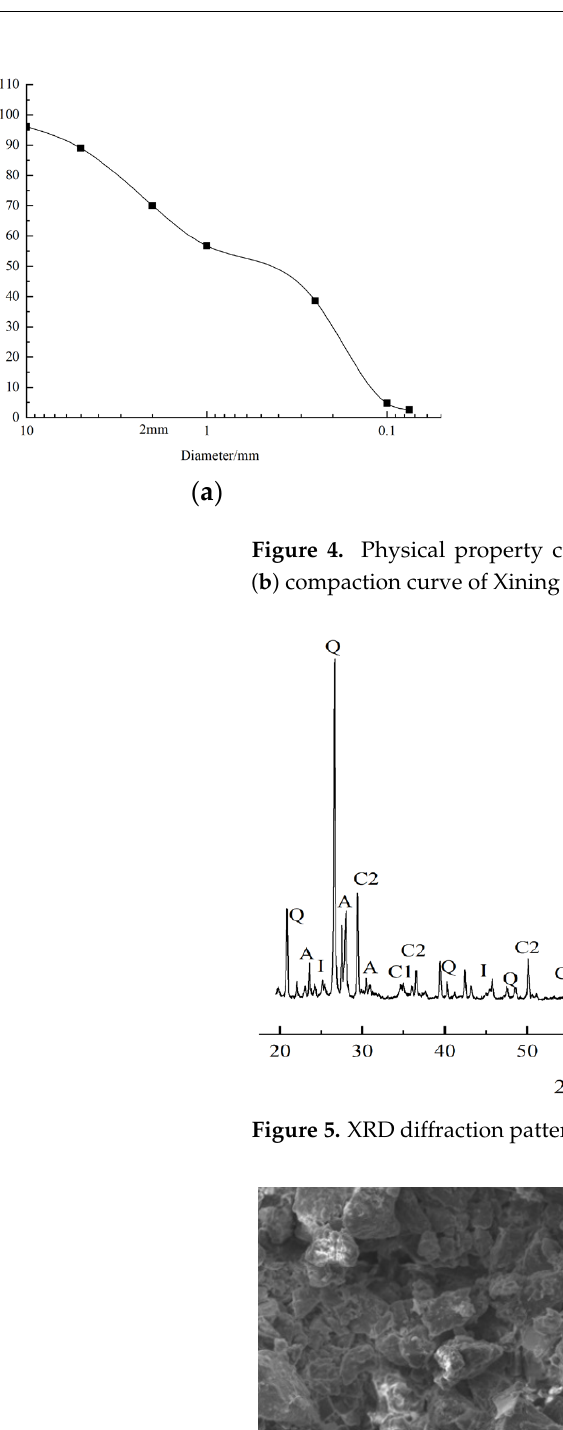
Figure 5. XRD diffraction pattern of loess.